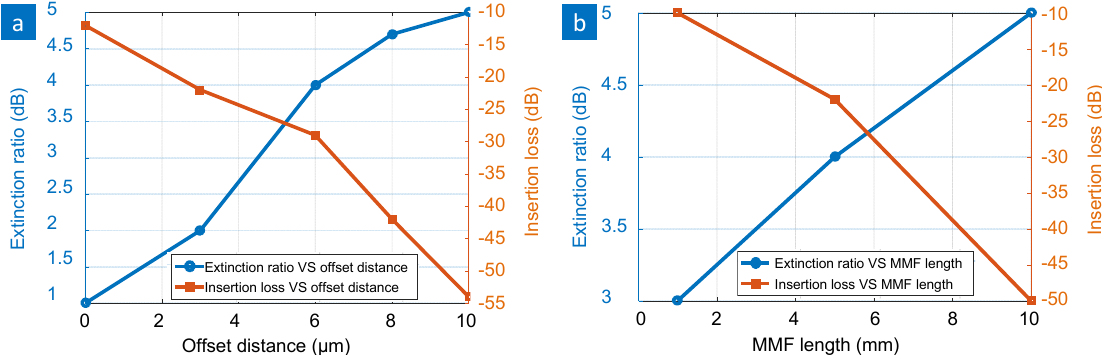
Fig. 7 | Optical spectra under different offset distances between SMF and TCF (a) and the desired spectrum obtained in the SCF in-line interferometer (b).